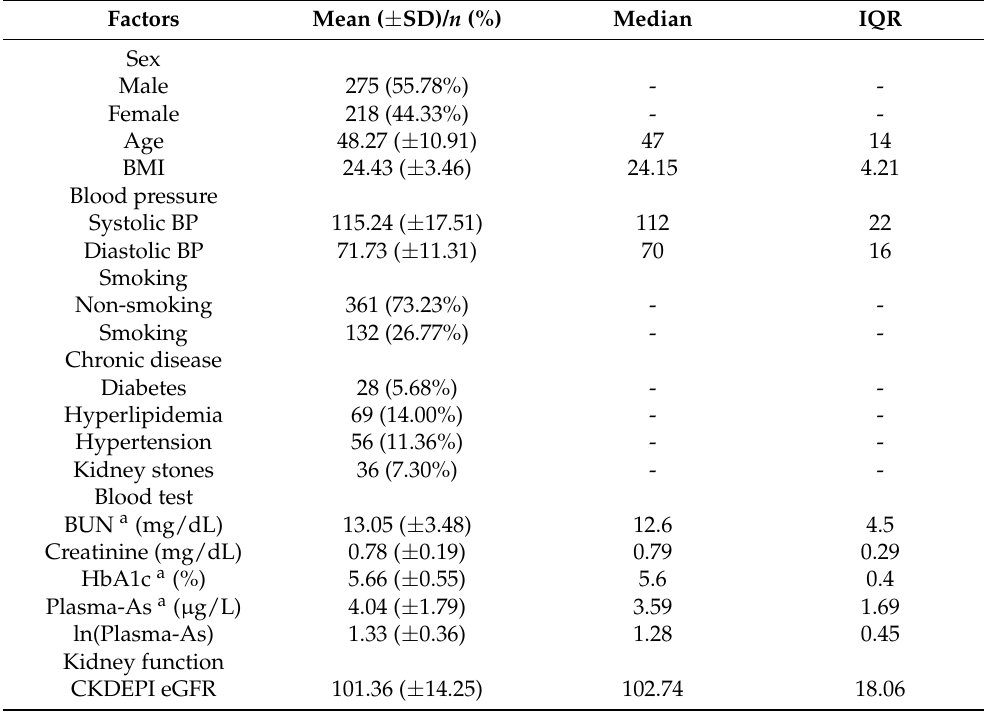
Table 1. Characteristics of study population.